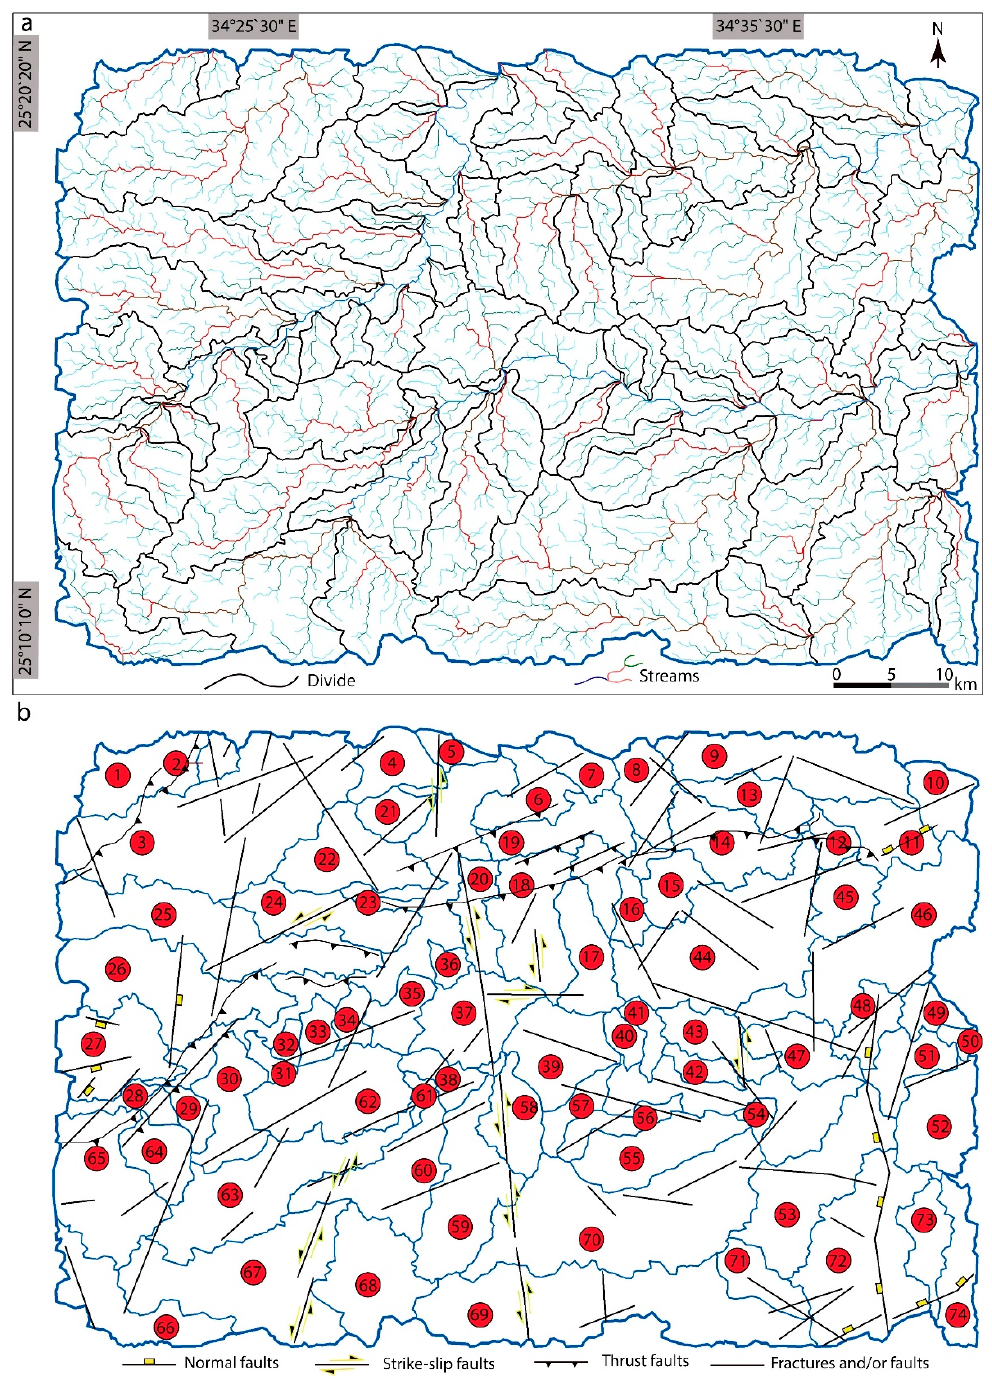
Figure 4. ( a ) Drainage and sub-catchments extracted from ASTER-DEM data. ( b ) Map showing the reference numbers of the sub-catchments and the tectonic features of the study area.